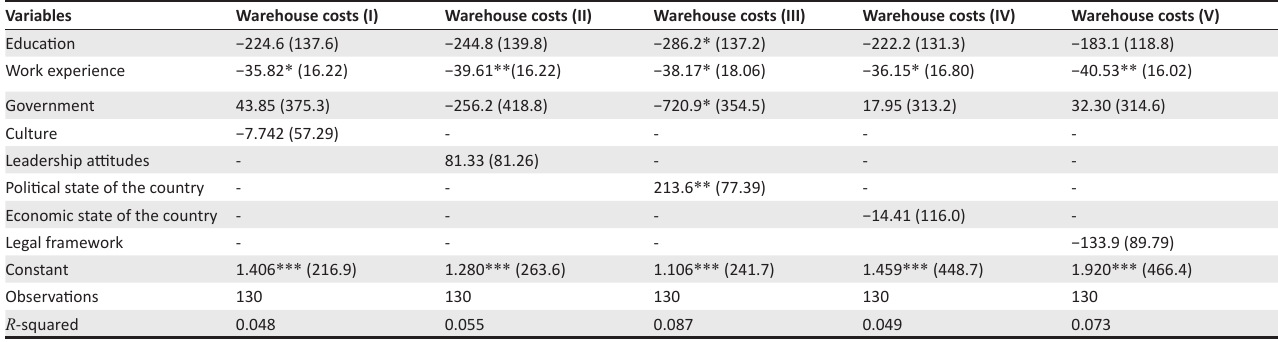
TABLE 5: The impact of drought relief enablers on warehouse